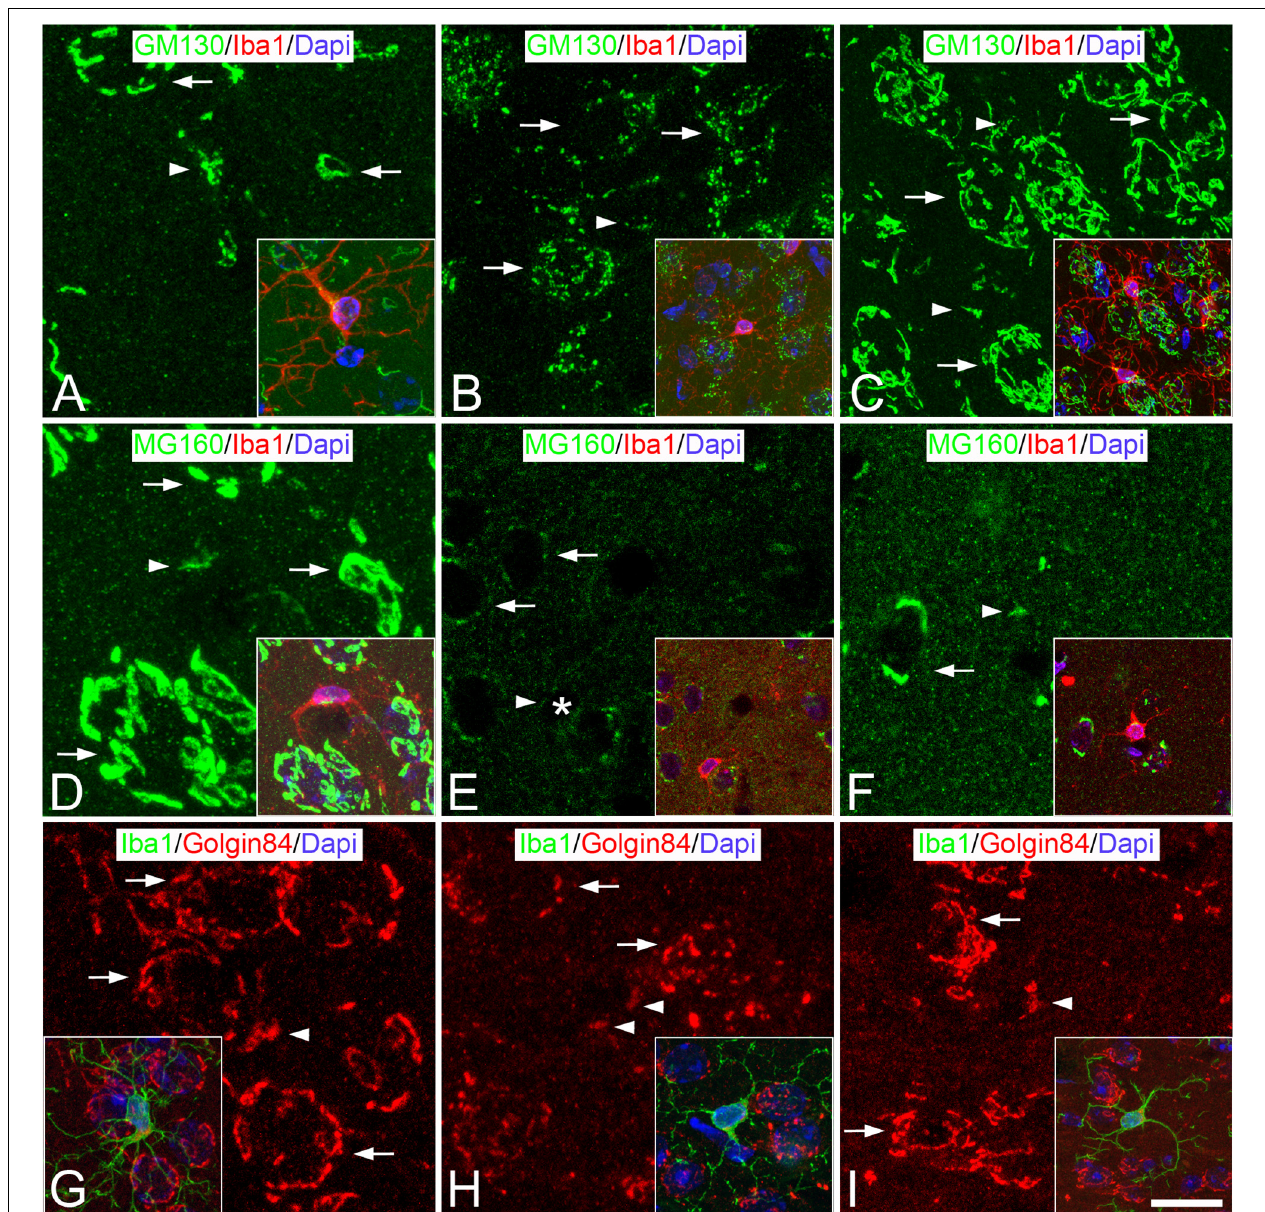
FIGURE 2 | Distribution of GA proteins in neocortical microglial cells throughout the hibernation cycle of the hamster. Images taken from neocortical sections double-immunostained for GM130/Iba-1 (A–C) , MG160/Iba-1 (D–F) and Golgin84/Iba-1 (G–I) showing the distribution of GA proteins in the GA of microglial cells (identified in insets by Iba-1 immunostaining) from euthermic hamsters (A,D,G) , hamsters at torpor (B,E,H), and arousal (C,F,I) . Note the apparent reduction in size and in intensity of MG160 immunostaining of the GA elements of microglial cells during torpor and recovery in arousal. Scale bar shown in panel (I) indicates 6.8 µ m in all panels, and 15 µ m in the